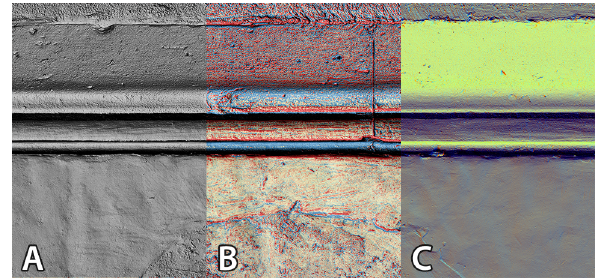
Figure 9 . Three visualisations of the upper central part of the final raster DSM: A) contrast-enhanced omnidirectional hillshade (30° elevated light source); B) red-yellow-blue colour- coded local relief model (radius 30 cells, [-80, 80] µm cut-off values] fused with the omnidirectional hillshade of A; C) multiple hillshade (see Figure 7 for the parameters). Note that the seam between both raster sources is